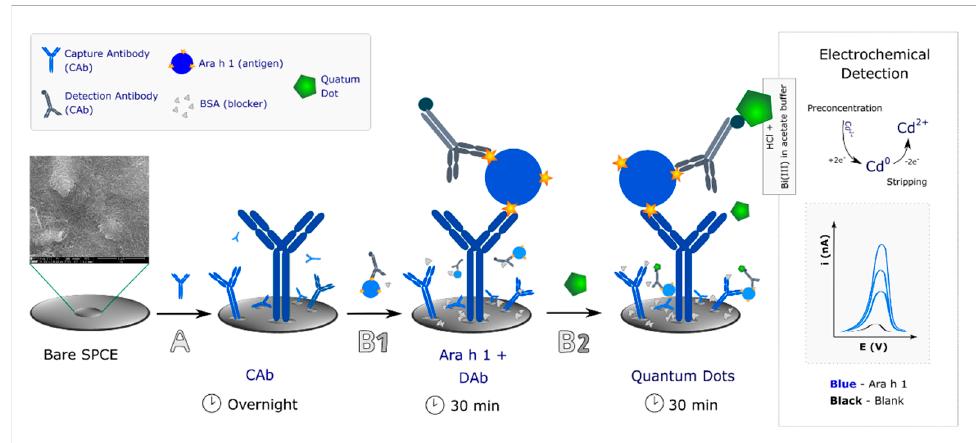
Figure 1. Schematic representation of the construction of the electrochemical immunosensor. ( A ) Incubation with CAb, followed by incubation with ( B1 ) a mixture solution containing the allergen (Ara h 1) and DAb, and ( B2 ) a Quantum Dot solution. For electrochemical detection, after addition of HCl, to dissolve the QD, and Bi(III), to form a bismuth film, differential pulse anodic stripping voltammetry was used. Representative voltammograms of increasing Ara h 1 concentrations are exemplified.